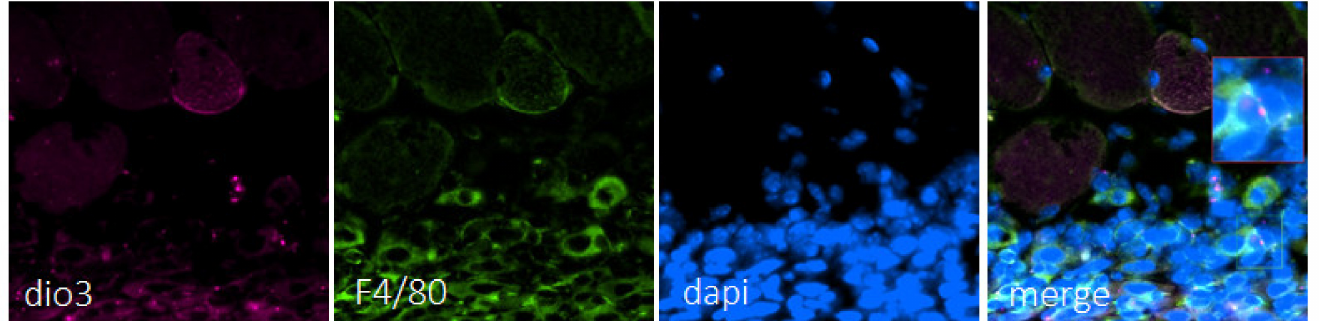
Figure 6. Dio3 mRNA in pink was predominately expressed in macrophages (F4/80 immunostaining, green; nucleus DAPI staining, blue). The merged panel shows that Dio3 mRNA in pink was present in macrophages. Images are representative of in situ hybridization for Dio3 in injured muscle on day 1 while F4/80-stained images are representative of macrophages in one of five different mice analyzed ( n = 5). Scale bar = 50 µm.